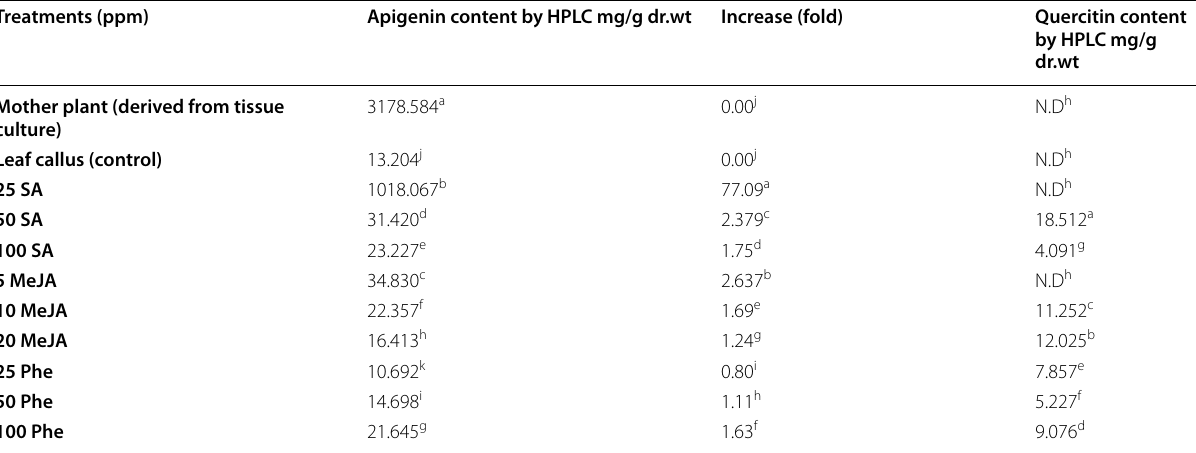
Table 9 Apigenin and quercitin content as an active compounds identified by HPLC in Dimocarpus longan callus treated by biochemical elicitors and precursor